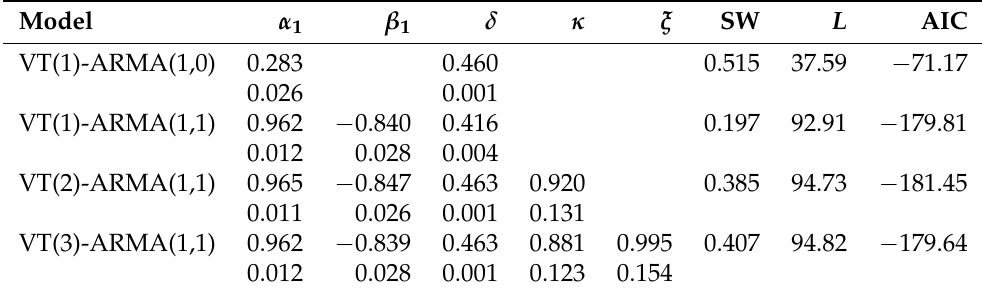
Table 1. Analysis of daily Bitcoin return data 2016–2019. Parameter estimates, standard errors (below estimates) and information about the fit: SW denotes Shapiro–Wilks p -value; L is the maximized value of the log-likelihood and AIC is the Akaike information